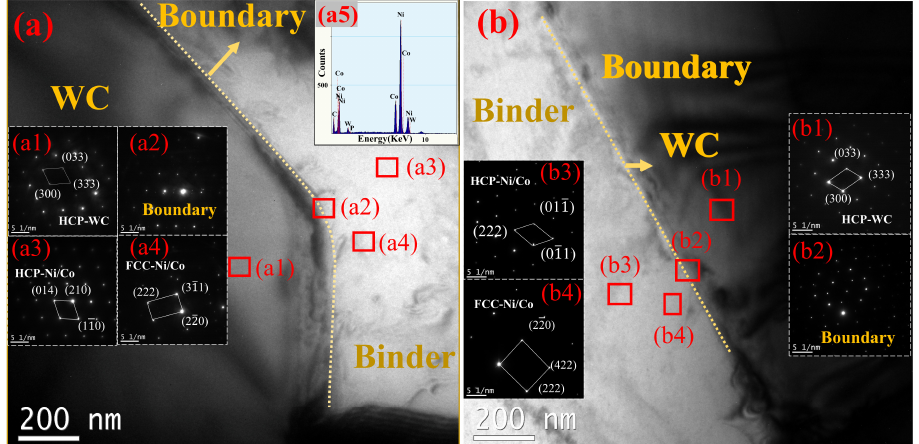
Figure 5. The TEM image of WC-Ni/Co cemented carbide: ( a ) WC-Ni/Co EP ; ( b ) WC-Ni/Co CP , in which (a1) is black zone diffraction; (a2) is two phase interface diffraction; (a3) and (a4) are the white area diffraction; (a5) is the eds in a4; and also (b1) is black zone diffraction; (b2) is two phase interface diffraction; (b3) and (b4) are the white area diffraction